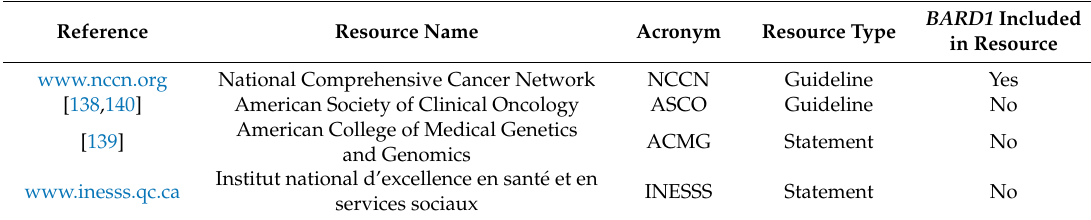
Table 3. Publicly available resources reviewed for recommendations for management of carriers of a potentially pathogenic BARD1